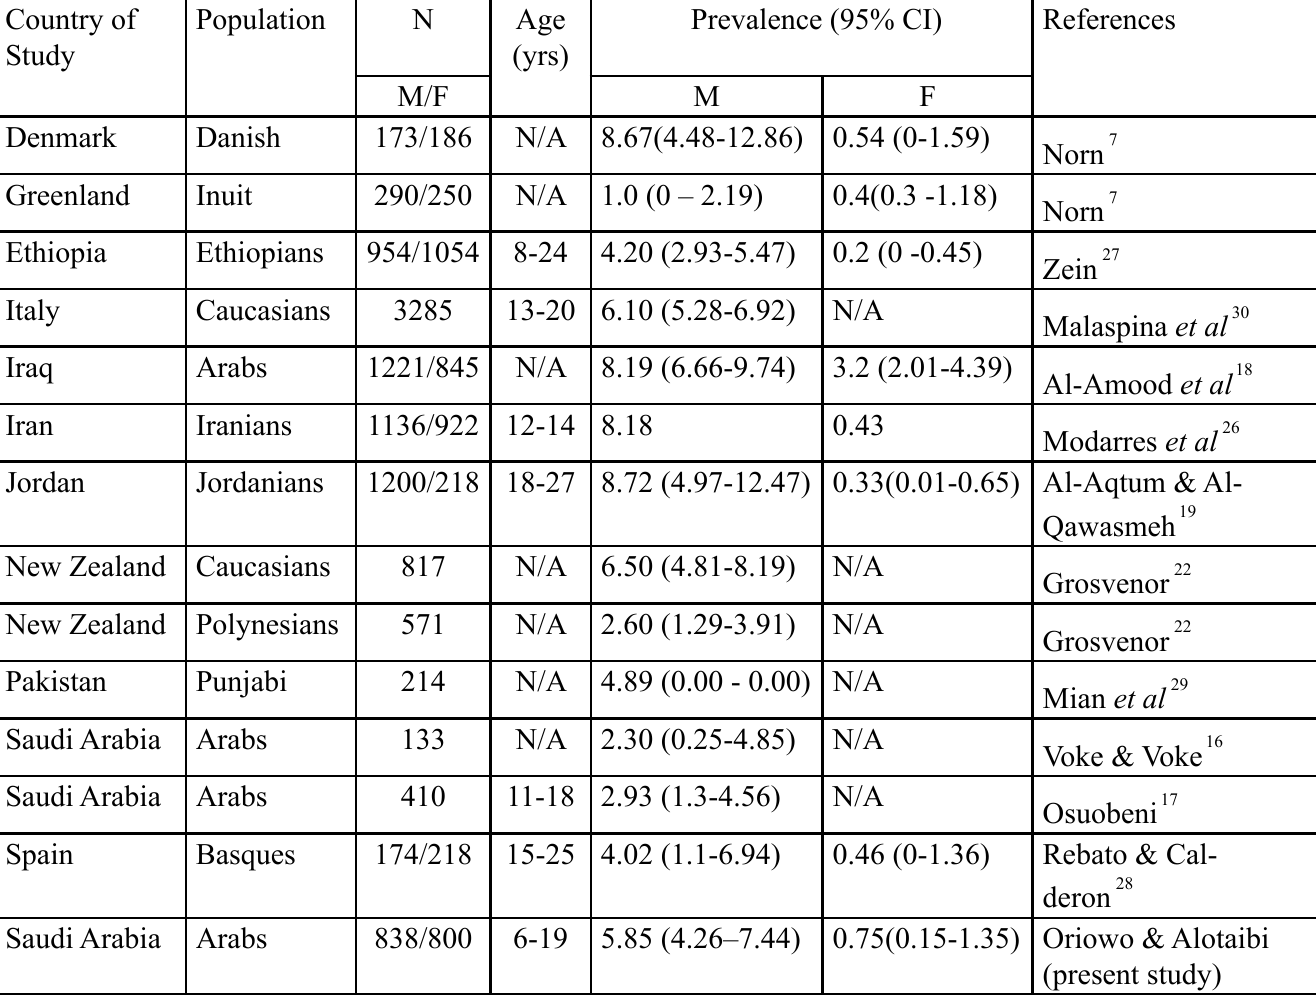
Table 2. Comparison of the present study results (prevalence %) with samples of previous studies from different populations of certain